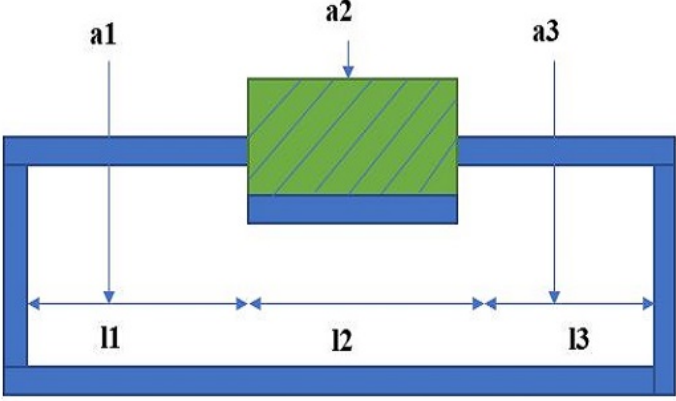
Figure 1. Longitudinal section of the sensor under applied pressure.